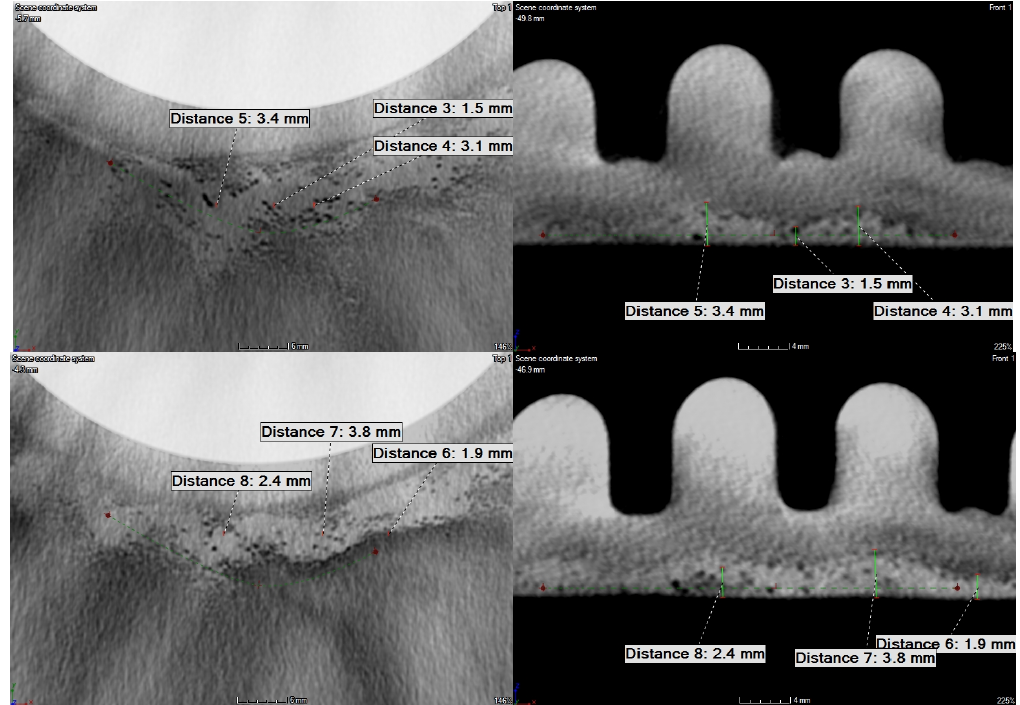
Figure 19. The selected detailed views of the tomogram of the smaller disk with dimensioned lower density areas.